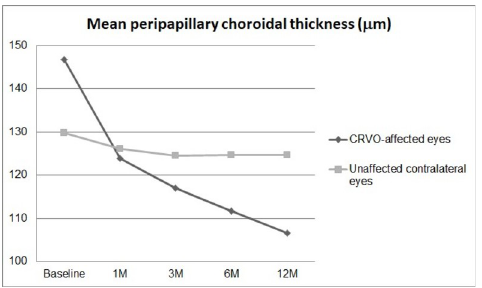
Fig 3. Changes in mean subfoveal choroidal thickness (SFCT) in central retinal vein occlusion (CRVO)-affected eyes and unaffected contralateral eyes. The mean SFCT was not significantly different between the CRVO-affected eyes and the contralateral eyes at each follow-up point (P = 0.782 at baseline; P = 0.815 at 1 month; P = 0.872 at 3 months; P = 0.715 at 6 months; and P = 0.609 at 12 months). https://doi.org/10.1371/journal.pone.0255182.g003 mean PCT between CRVO-affected eyes and contralateral eyes at any follow-up time point (P = 0.314 at baseline; P = 0.782 at 1 month; P = 0.815 at 3 months; P = 0.693 at 6 months; and P = 0.343 at 12 months). Changes in mean PCT are presented in Fig 4.